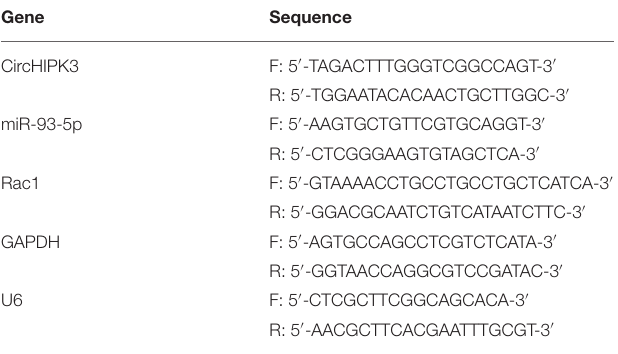
TABLE 1 | Primer sequences for RT-qPCR.